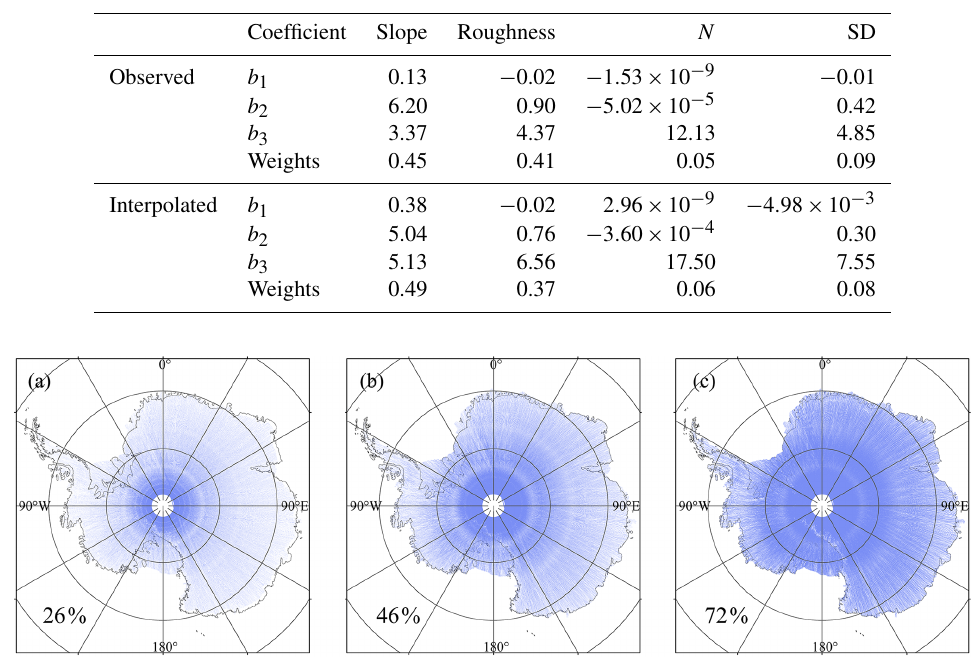
Table 3. Fitting coefficients and weights used for the DEM uncertainty estimation.